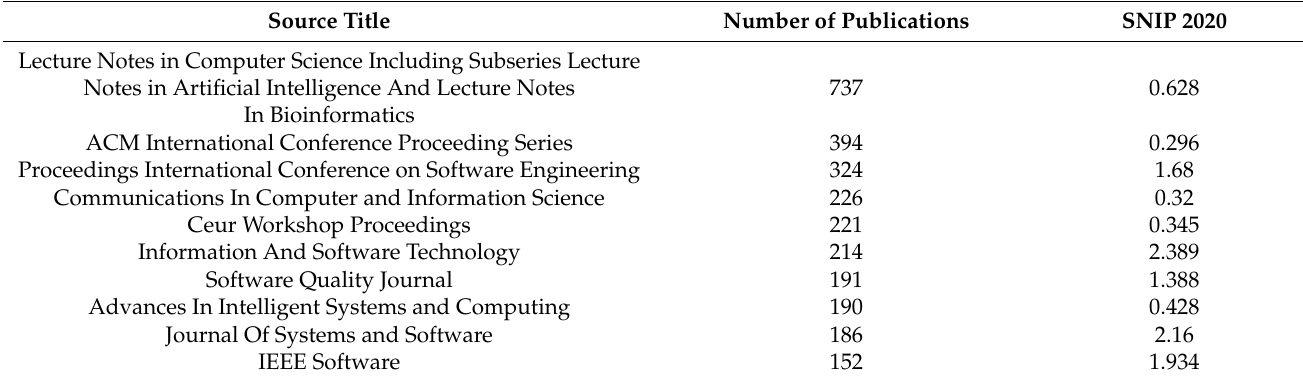
Table 3. Most prolific